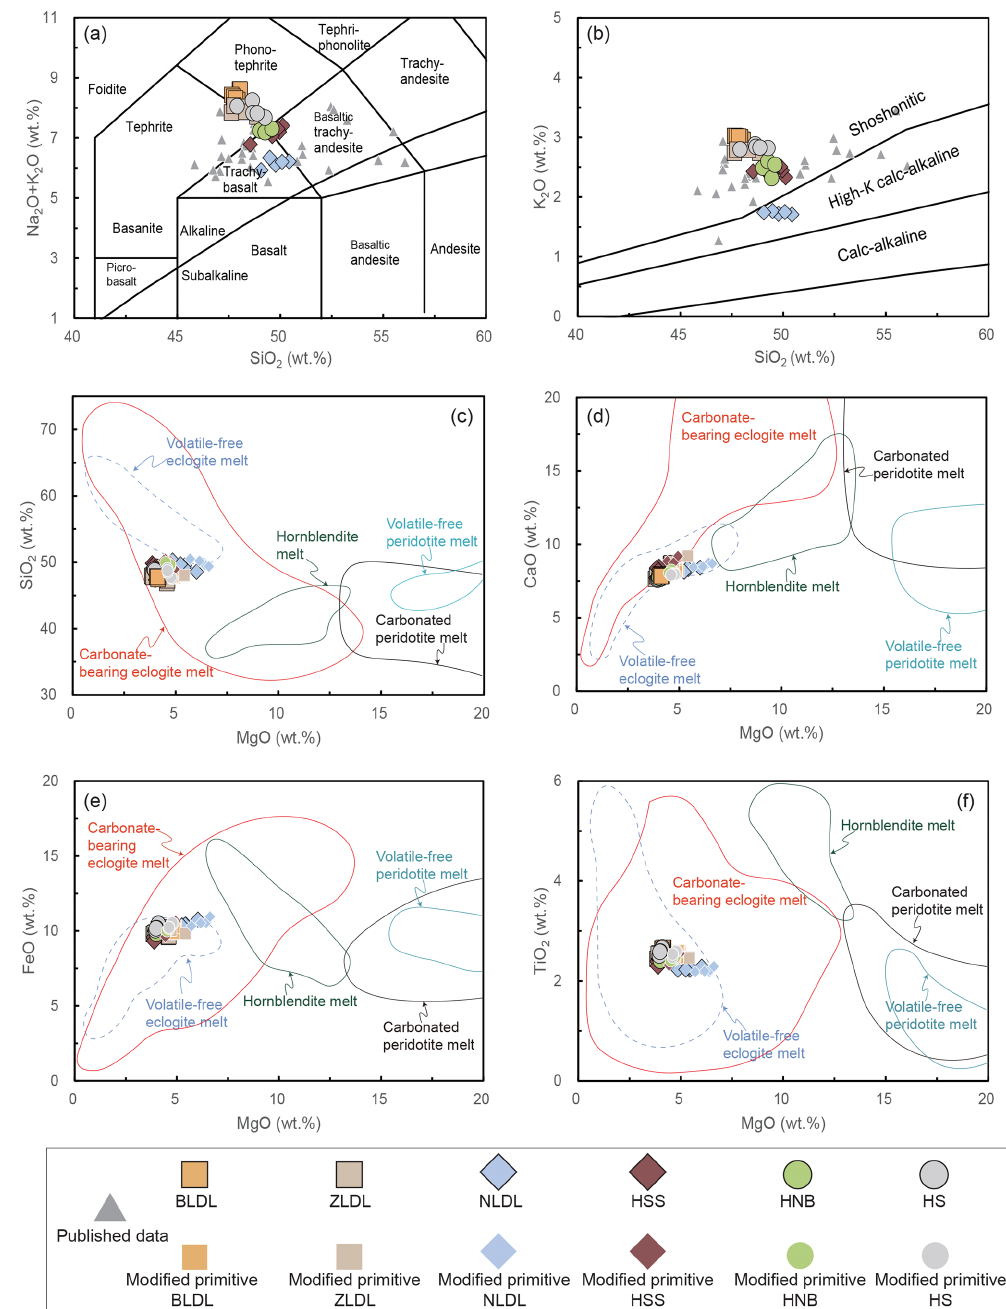
Figure 6. (a) Total alkali–silica (TAS) diagram (after Le Bas et al., 1986, and the line divides alkaline and sub-alkaline rocks after Irvine and Baragar, 1971) for volcanic rocks in the WVF. (b) K 2 O-vs.-SiO 2 correlation diagram (after Peccerillo and Taylor, 1976). (c) SiO 2 vs. MgO. (d) CaO vs. MgO. (e) TFeO vs. MgO. (f) TiO 2 vs. MgO. Published literature data of the WVF are compiled from Fan et al. (2014) and Zhao et al. (2019). Also shown for comparison are experimental silicate melts and carbonated silicate melts of carbonate-bearing eclogites (Dasgupta et al., 2006; Gerbode and Dasgupta, 2010; Litasov et al., 2011; Kiseeva et al., 2012; Thomson et al., 2016; Elazar et al., 2019) and carbonate-bearing peridotites (Hirose, 1997; Dasgupta et al., 2007; Foley et al., 2009; Litasov et al., 2011; Dasgupta et al., 2013; Ghosh et al., 2014; Dvir and Kessel, 2017; Pinté et al., 2021), hornblendite (Pilet et al., 2008), volatile-free eclogites (Yaxley and Green, 1998; Pertermann and Hirschmann, 2003; Spandler et al., 2008), and volatile-free peridotites (Takahashi and Kushiro, 1983; Takahashi and Scarfe, 1985; Hirose and Kushiro, 1993; Takahashi et al., 1993; Walter, 1998; Davis et al., 2011) at > 2 . 5GPa. The symbols with a black line represent the whole rock composition of the WVF, and the symbols with a white line represent the primitive melt composition after fractional crystallization correction (see details